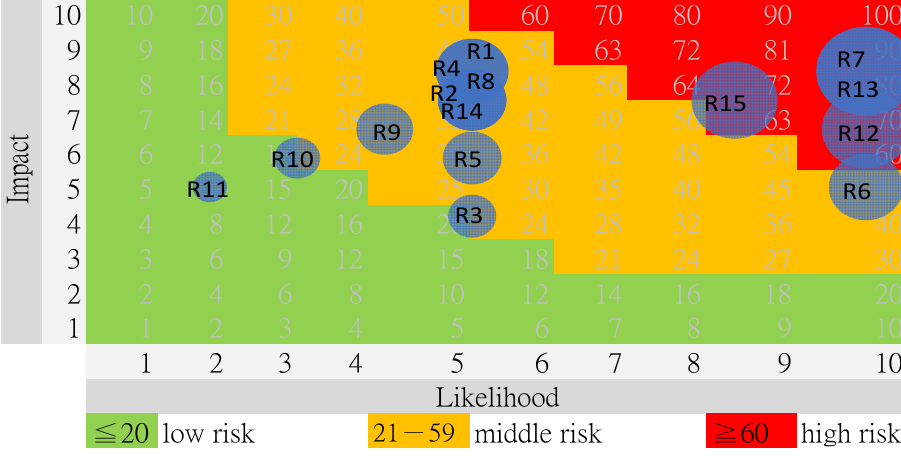
Figure 6. Risk Table 3. Five cases and community resilience.